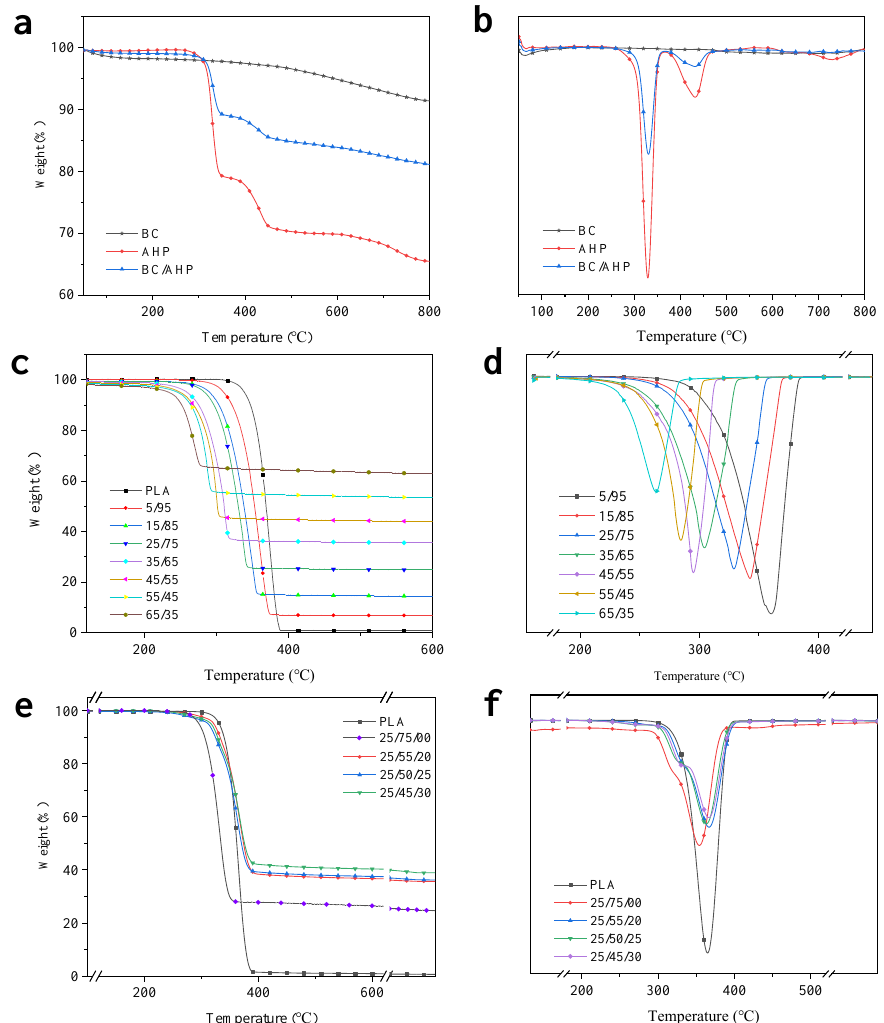
Figure 2. TG and DTG curves for ( a , b ) BC and AHP, ( c , d ) BC / PLA mixes, and ( e , f ) BC / PLA / AHP mixes. Table 2. Thermogravimetry (TG) test data of BC, AHP, and BC / AHP flame-retardant systems under N 2 atmosphere.